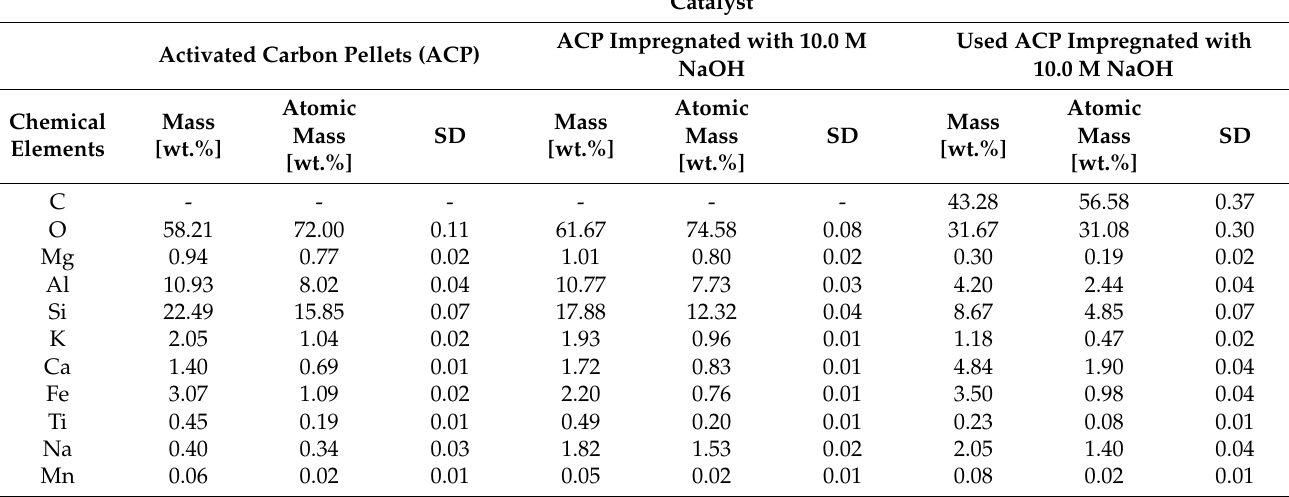
Table 2. Percentages in mass and atomic mass of activated carbon pellets, activated carbon pel- lets impregnated with 10.0 M NaOH after calcination at 600 ◦ C and 03 h, and activated